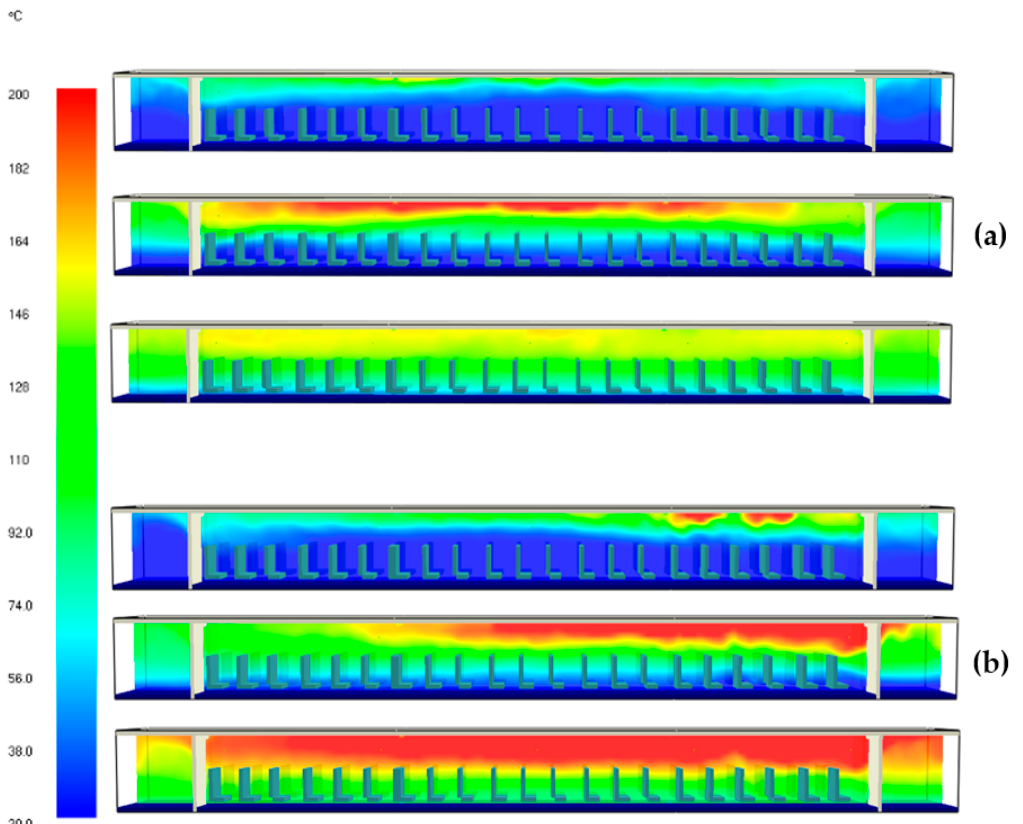
Figure 6. Gas temperature variations along the central plane of carriage after 40 s, 80 s and 120 s for ( a ) central ignition and ( b ) front ignition.